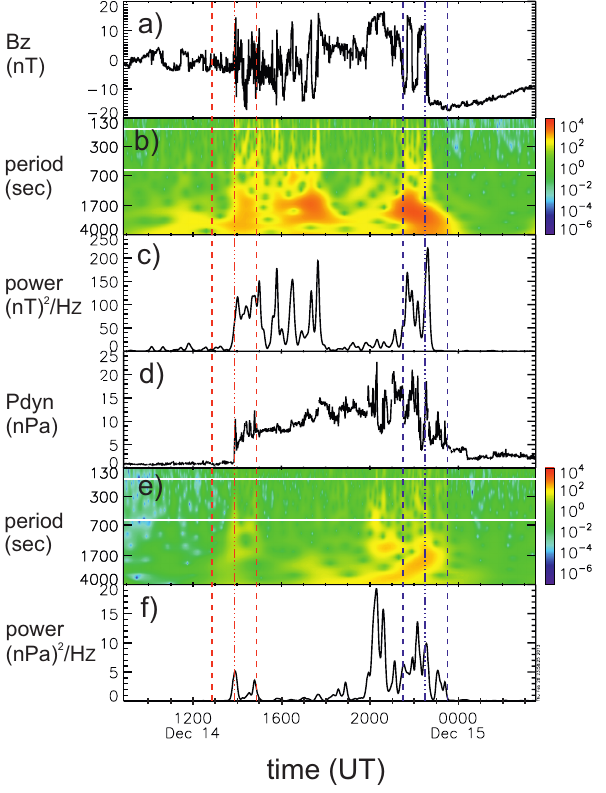
Fig. 2. Example event on 14 December 2006. The panels show the following from top to bottom: (a) IMF Z component in GSM ( B Z ), (b) wavelet spectrogram for B Z , (c) B Z ULF power, (d) solar wind P dyn , (e) wavelet spectrogram for P dyn , and (f) P dyn ULF power. The red dash-dotted line marks the shock, and the blue dash-dotted line the leading edge. The 1h regions adjacent to the shock and the leading edge are bounded by the pairs of dashed lines. In panels (b) and (e) the pair of white lines bounds the 3 to 10min frequency range we have used to calculate the ULF powers in panels (c) and (f) .